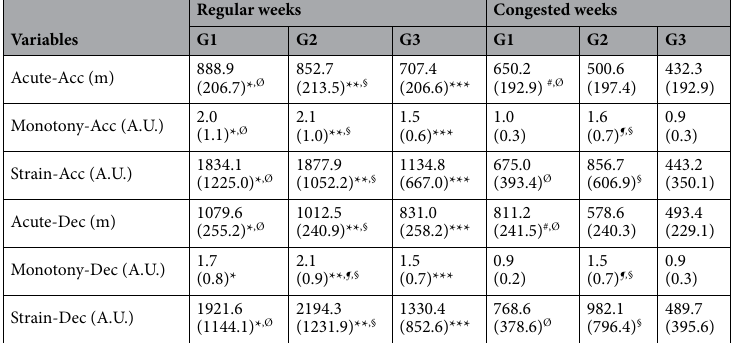
Table 3. Mean (standard deviation) of the acute, monotony, and strain indices for the total distance covered in high-acceleration (Acc; ≥ 2 m·s -2 ) and high-deceleration (Dec; ≤ -2 m·s -2 ) according to congested fixture and matches’ participation. G1 = players who played ≥ 60 min; G2 = players who played < 60 min; G3 = players who did not participate of the match. * G1: Regular week > Congested week; ** G2: Regular week > Congested week; *** G3: Regular week > Congested week; # G1 > G2; Ø G1 > G3; ¶ G2 > G1; § G2 >